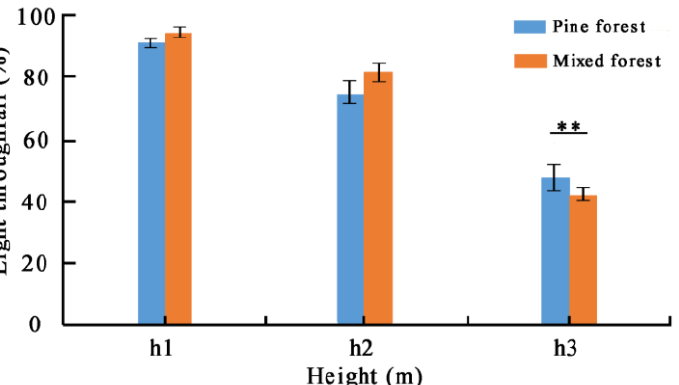
Figure 5. Comparison of light transmittance of three different positions for reference tree Masson pine in pure forest and mixed forest. ** indicates significance at p < 0.01 level. Additionally, the mean distance between Masson pine and neighboring trees (1.59 m) in mixed forest plots was significantly shorter than that in pine forest plot (2.77 m) ( p < 0.01) (Table 3). Table 3. Comparison of the difference in FBH, the ratio of live crown ratio and distance between Masson pine and neighboring trees in plots of pine forest and mixed forest in southern Jiangsu, eastern China (mean ± SE).